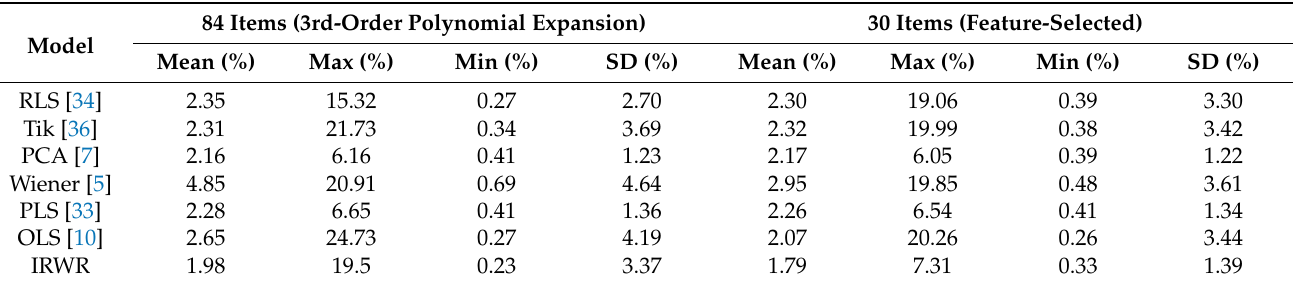
Table 4. Comparison of estimation accuracy in terms of CIEDE2000 using ten-fold cross-validation. 84 Items (3rd-Order Polynomial Model